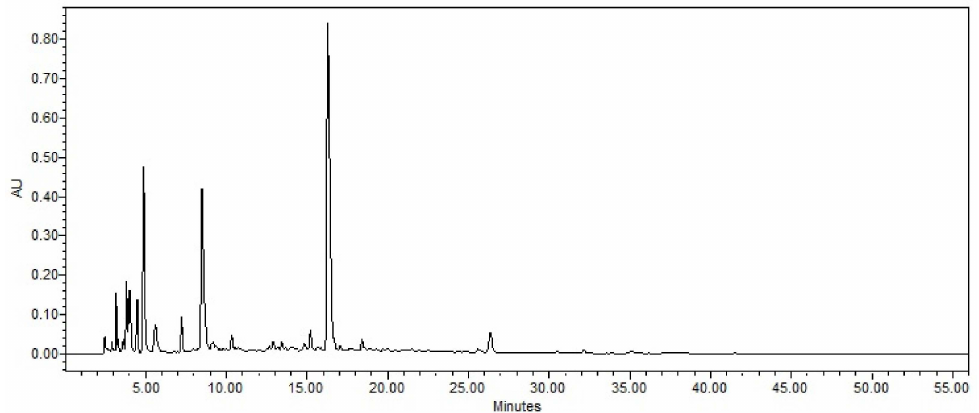
Figure A1. RP-HPLC separation of amaranth hidrolizated